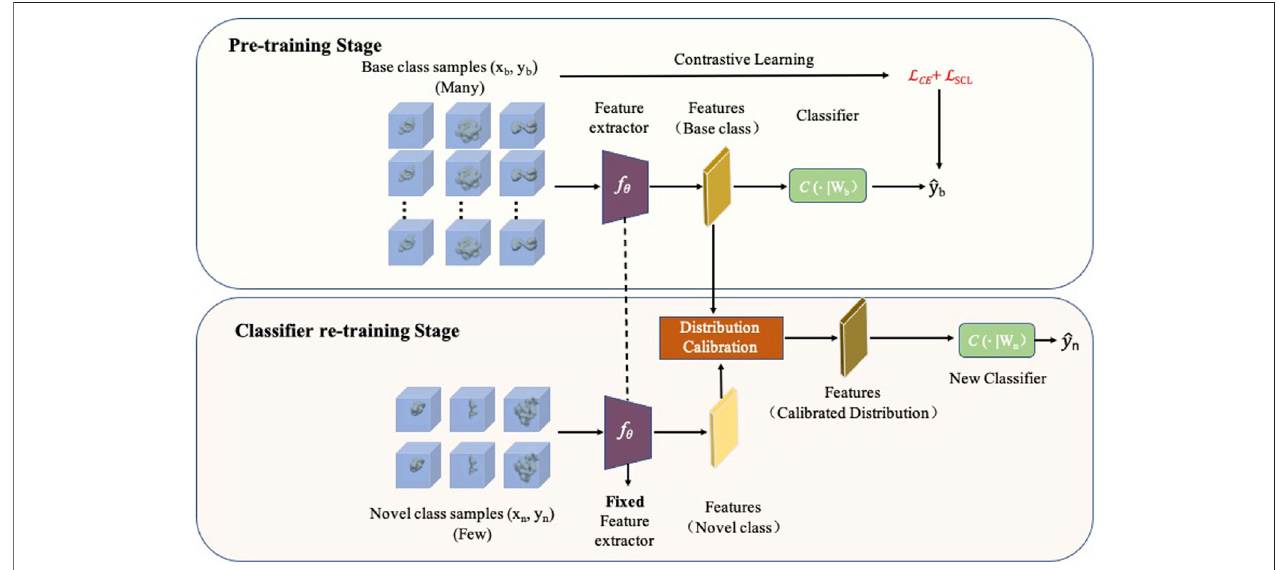
FIGURE 1 | Framework of FSCC. FSCC follows a two-stage training strategy. The fi rst training stage is a pre-training stage. FSCC pre-trains the model on a suf fi cient number of labeled macromolecules of base classes by contrastive learning. The second training stage is a classi fi er re-training stage. Here, FSCC re-trains the classi fi er with very few labeled macromolecules of novel class. To augment the inputs of the classi fi er, FSCC calibrates the distribution of novel classes and samples adequate features from calibrated distribution to re-train the classi fi er.